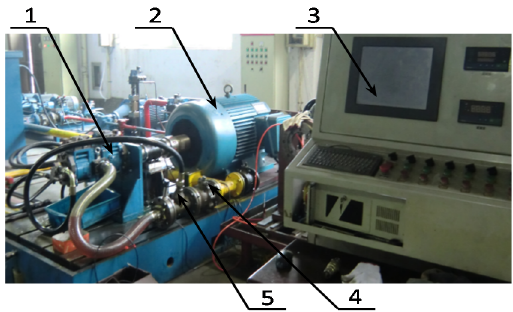
Figure 12. Experimental set-up: (1) Pump; (2) Motor; (3) Data acquisition machine; (4) Flow sensor; (5) Relief valve.